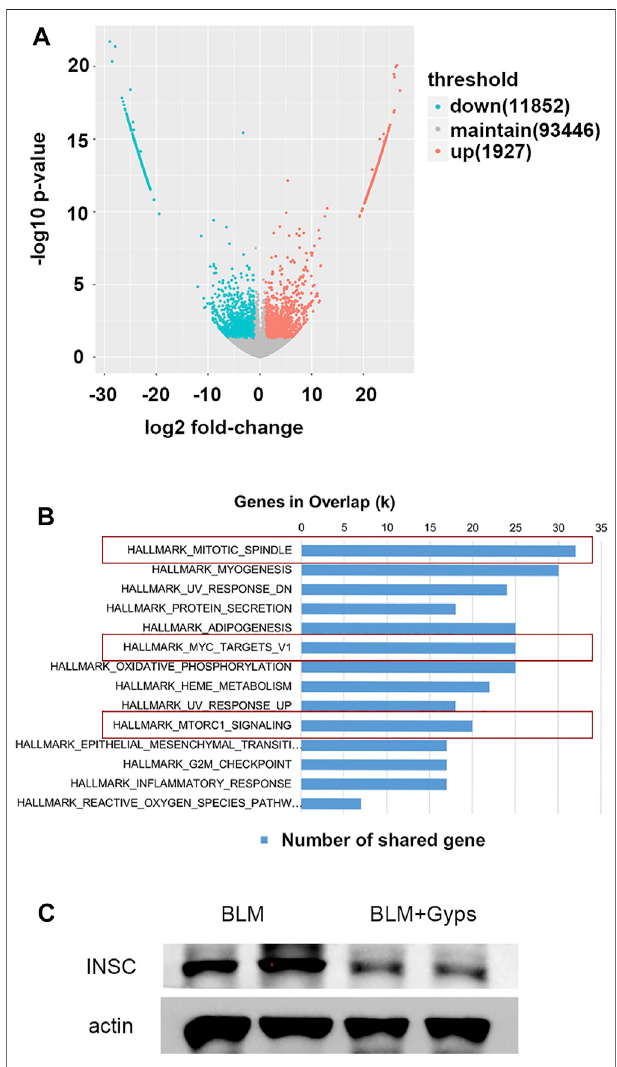
FIGURE 4 | RNA-seq analysis and Hallmark analysis. (A) RNA-seq analysiswasperformed, and the volcanoplot wasdemonstrated. (n (cid:1) 5mice/ group) (B) Results of Hallmark analysis on downregulated transcripts in the Gyps group compared with that in the control group. (C) Protein expression levels of INSC as detected by Western blotting. Gyps (cid:1) gypenosides, BLM (cid:1) bleomycin.